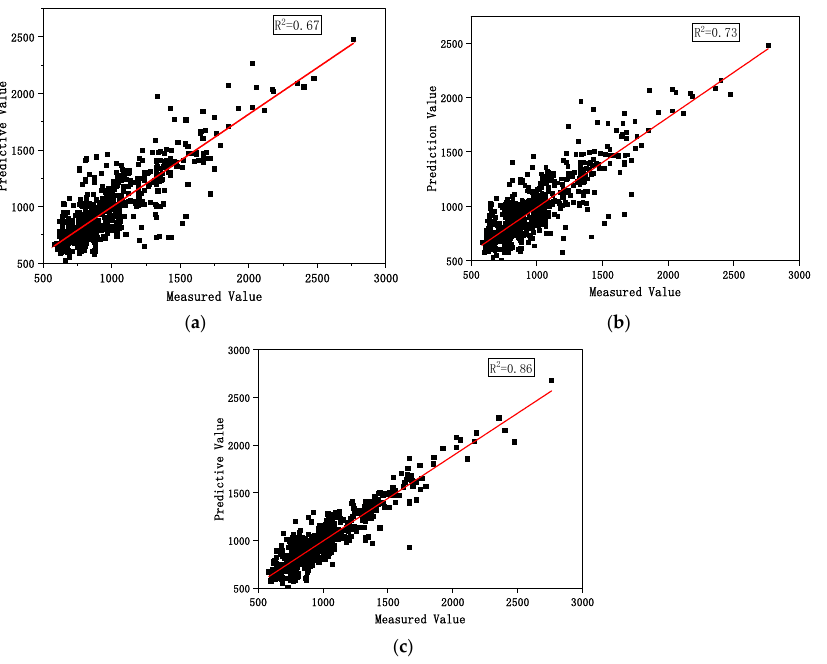
Figure 13. Scatter plot of predicted and measured values of three models. ( a ) BPNN model result, ( b ) ARIMA model result, and ( c ) ARIMA-BPNN model result.